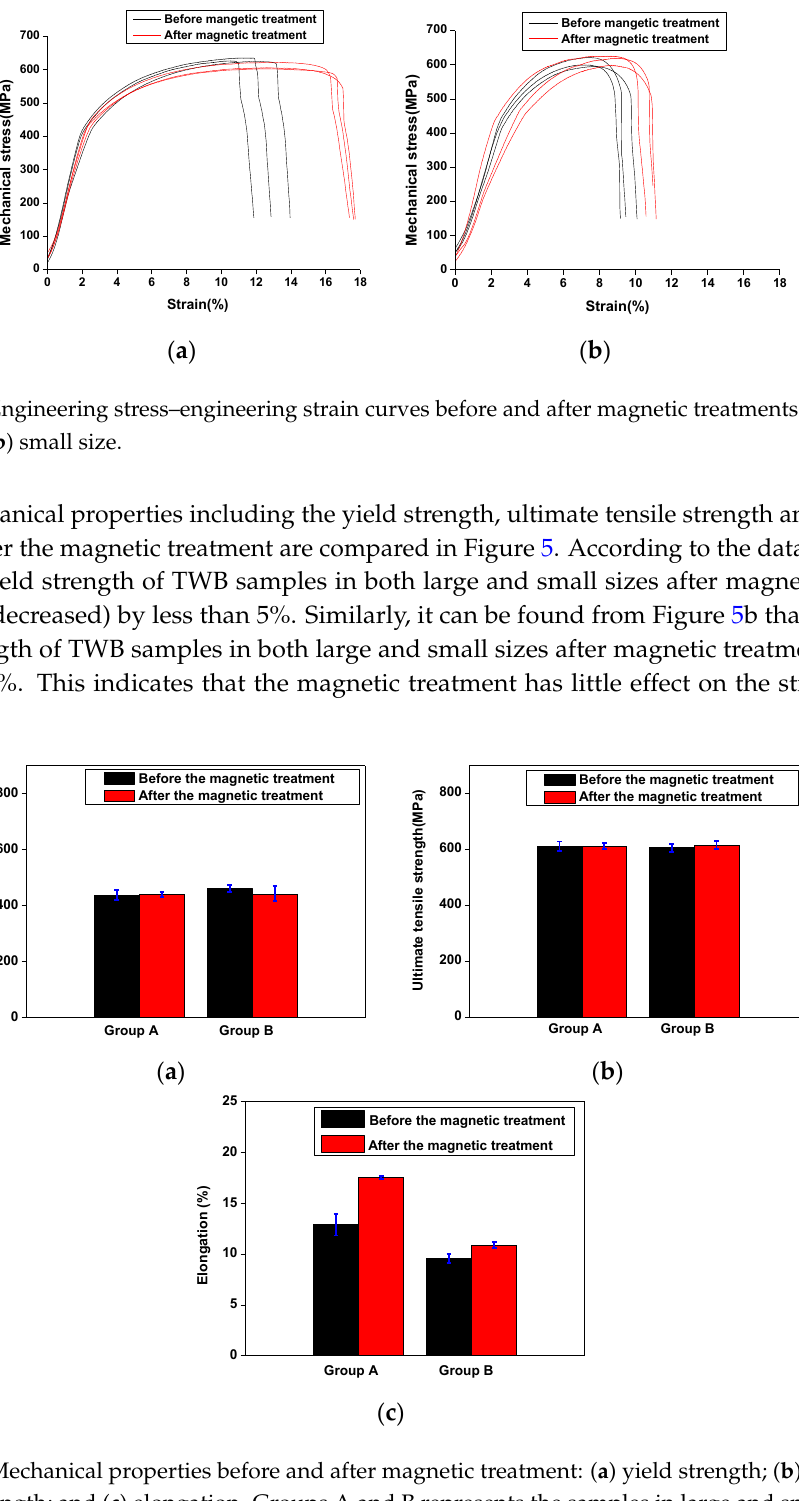
Figure 4. Engineering stress–engineering strain curves before and after magnetic treatments: ( a ) large size; and ( b ) small size.